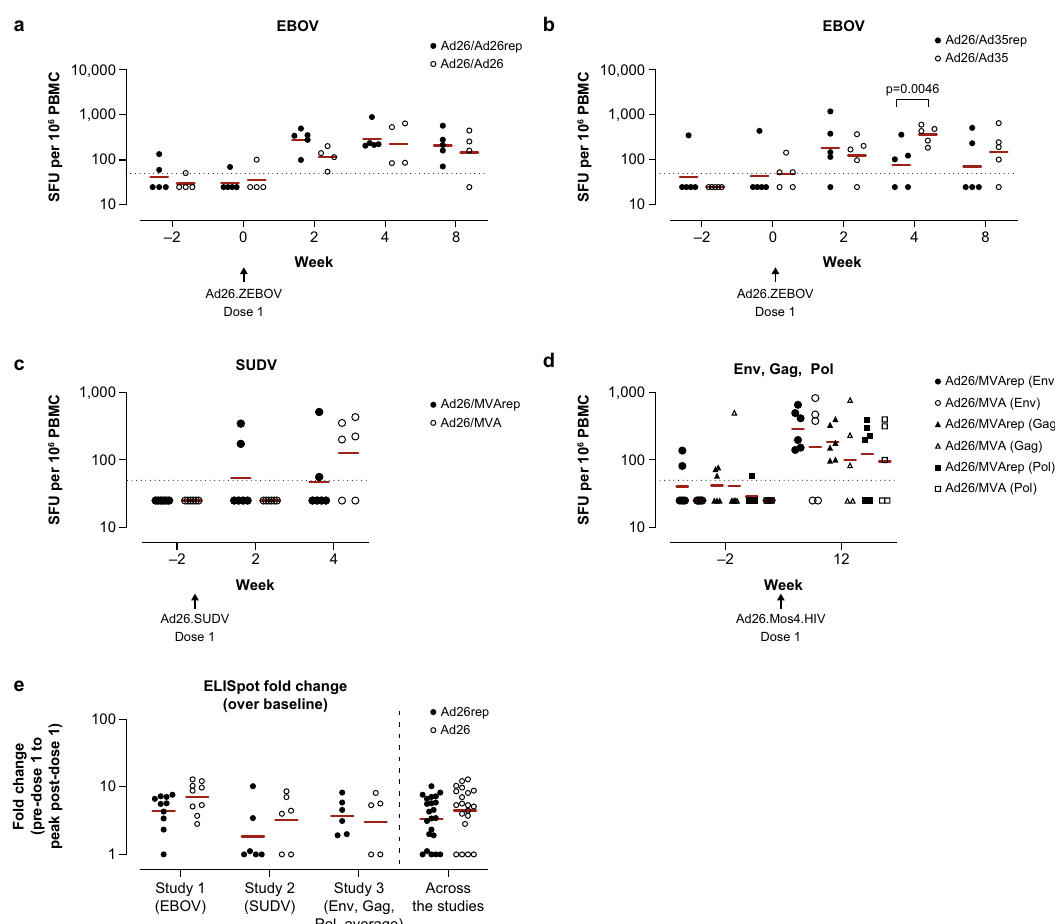
Fig. 3 Ad26 vaccine – elicited vector-immunity has minor impact on cellular immune responses induced by a fi rst dose of the B-series Ad26 vaccines in cynomolgus macaques. IFN γ ELISpot responses in PBMC ( a – d ) were determined after stimulation with pools of 15-mer peptides overlapping by 11 amino acids, covering the protein sequence of EBOV GP (EBOV) ( a , b ); SUDV GP (SUDV) ( c ); and Env, Gag, and Pol ( d ). Shown are background-subtracted values per animal of animals receiving Ad26 regimen encoding EBOV GP ( a , b ), regimen encoding SUDV GP ( c ), and regimen encoding Mos4.HIV ( d ). Animals that received an Ad26 vaccine during the A-series are annotated as Ad26/Ad26rep ( a ), Ad26/Ad35rep ( b ), and Ad26/MVArep ( c , d ). In a – d , the dotted line represents the assay threshold of 50 SFU/10 6 PBMC. Red bars depict geometric group means. In ( e ), the fold-change in IFN γ SFU/10 6 PBMCs is depicted and corresponds to the change in response comparing pre – dose 1 to peak response post – dose 1 per animal. Ad26rep refers to animals vaccinated in the A-series, and Ad26 to animals that were not vaccinated during the A-series. The red horizonal line is the geometric mean. For all 3 studies, the baseline (pre – dose 1) was de fi ned as the time point just prior to dosing (studies 1 – 3, week – 2). Pairwise comparison of the difference between pre-exposed animals and unexposed animals per time point was performed for data in ( a – d ), summarized in Supplementary Table 1. An ANOVA was performed over the fold- changes per study and across the 3 studies over the data shown in ( e ), summarized in Supplementary Table